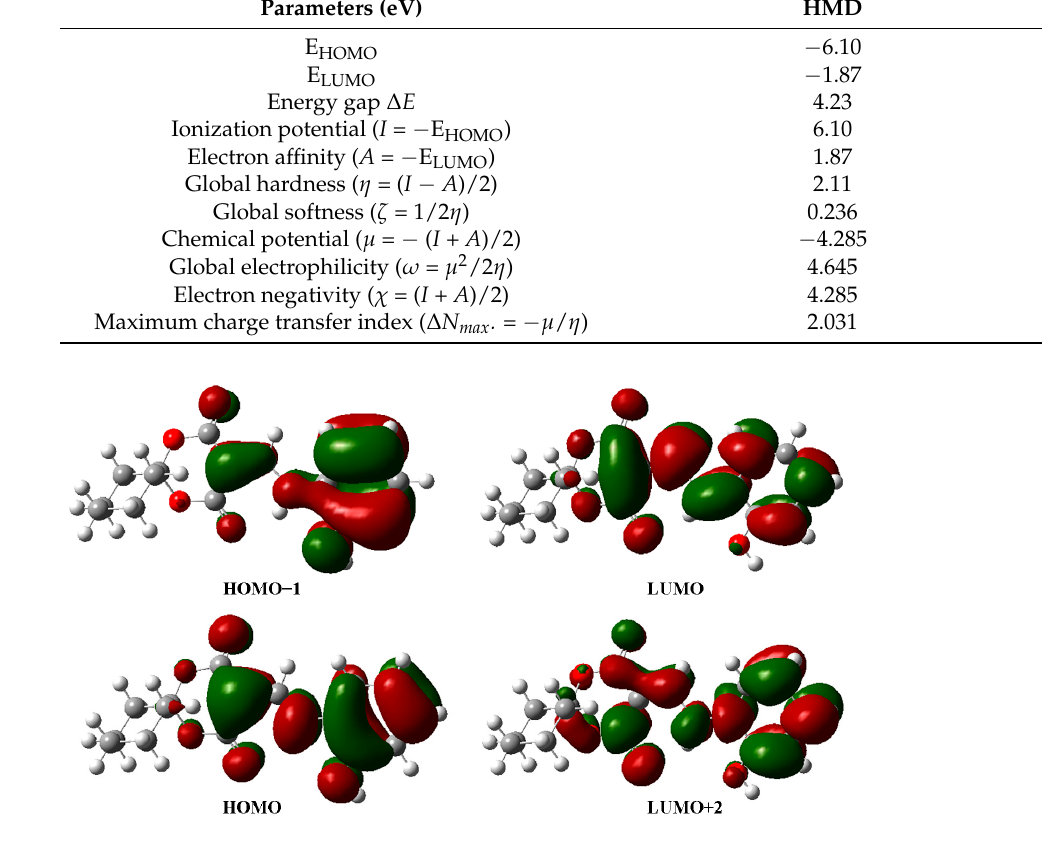
Figure 6. The four frontier molecular orbitals for HMD. Table 5. Global descriptor values for HMD.